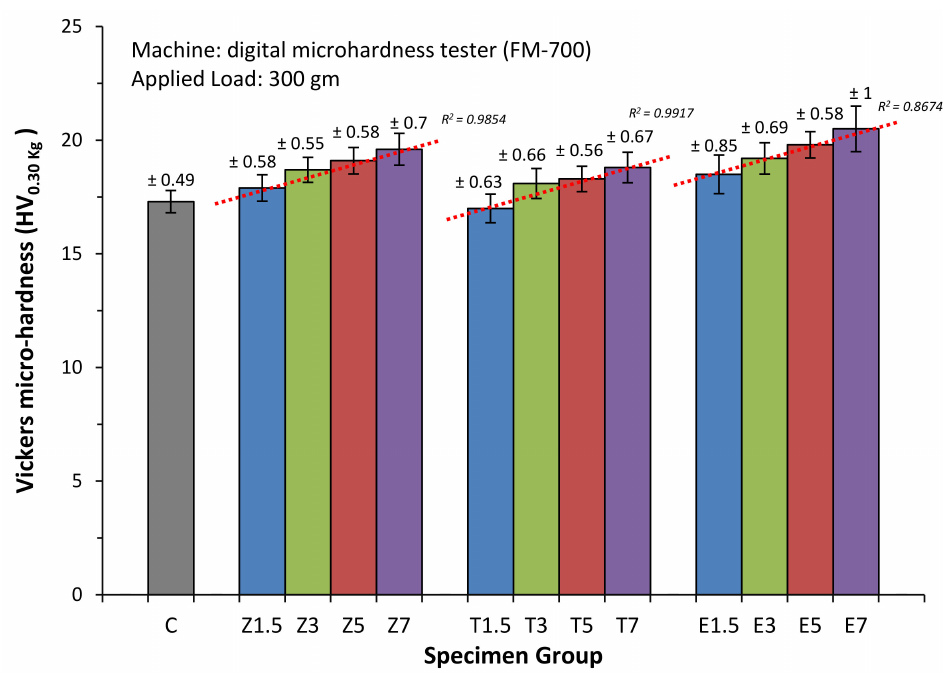
Figure 3. Mean surface hardness of all specimen groups with standard deviation